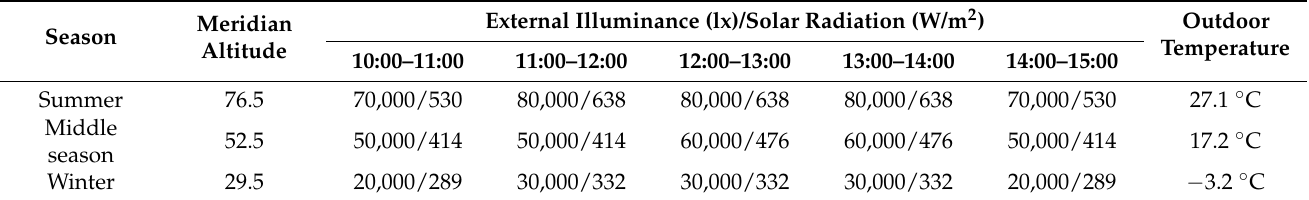
Table 7. Climatic settings for performance evaluation based on geographical